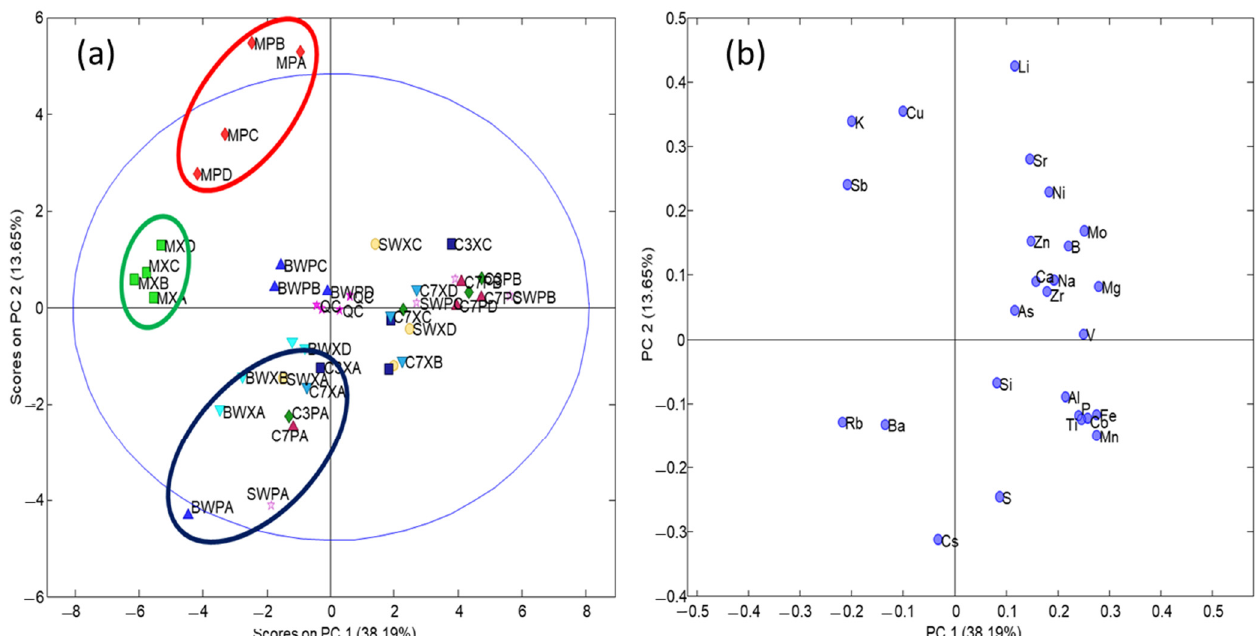
Figure 3. Plots of Scores ( a ) and Loadings ( b ) from the principal component analysis model. The red ellipse encompasses the musts of Pinot Noir, the green one the musts of Xarel · lo and the blue one the A qualities of wines and sparkling wines from both grape varieties. The thin blue ellipse is the confidence interval at 95%.